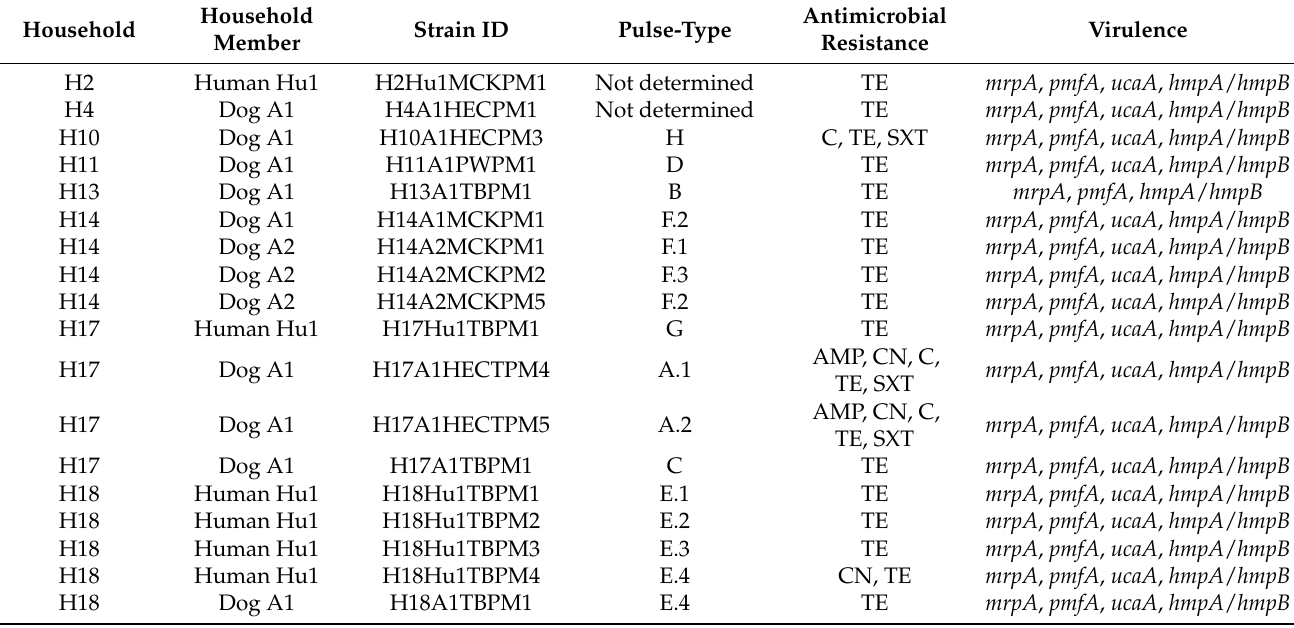
Table 1. Characterization of fecal P. mirabilis